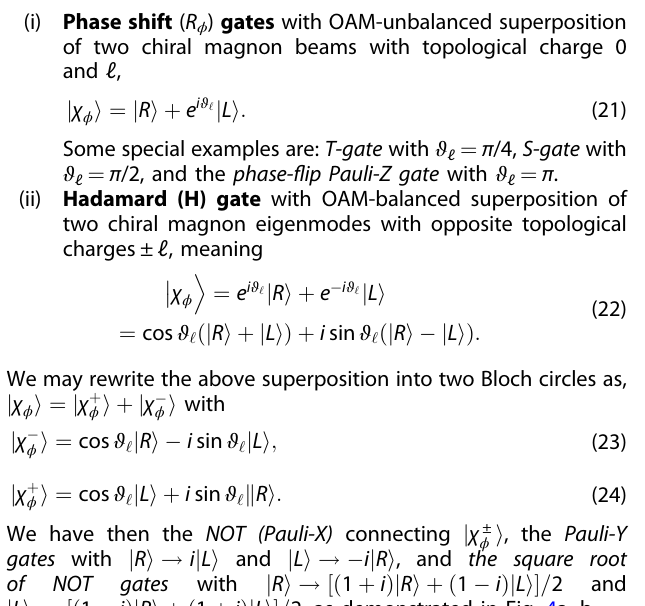
i ¼ h ∂ ´ n i (cid:5) cos2 ϑ ‘ t n s